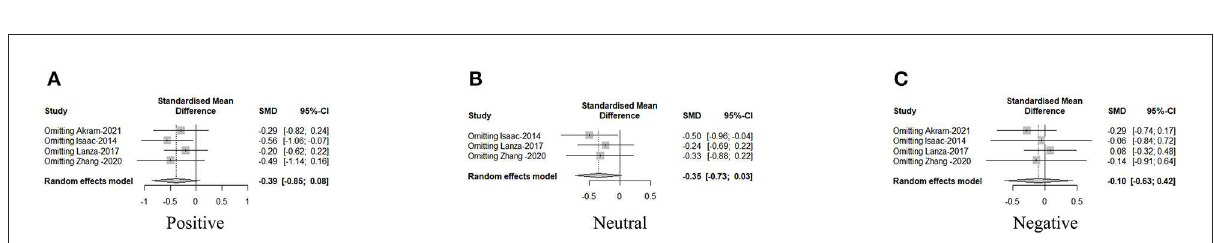
FIGURE3 Sensitivity analysis of first fixation time of positive emotional stimulus (A) , neural emotional stimulus (B) , and negative emotional stimulus (C) .